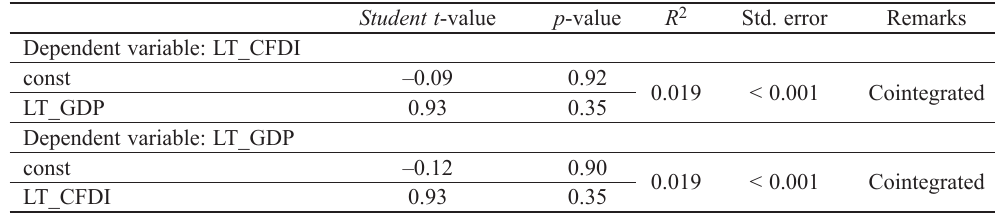
Table 5. Results of EG cointegration tests for Lithuania Student t -value Std. error